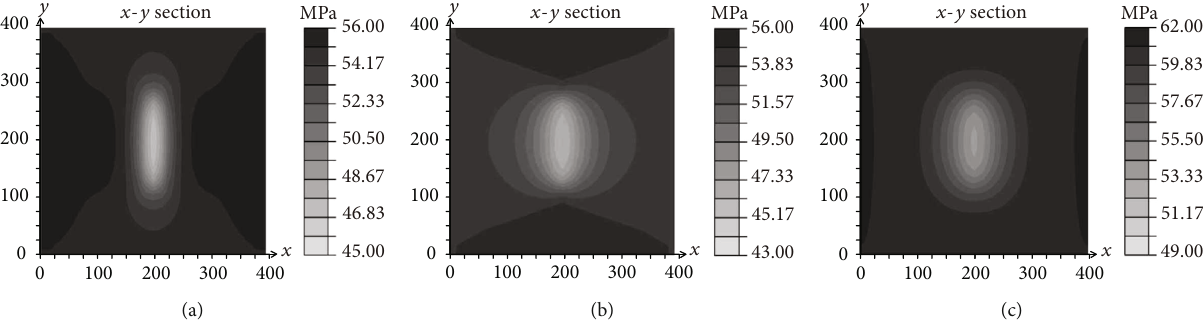
Figure 6: (a), (b), and (c) present the principal stress in the x -direction, y -direction, and z -direction without considering the in fl uence of the permeability tensor of natural